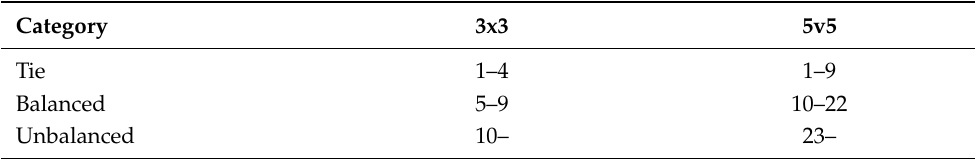
Table 1. Categorization of games based on score difference